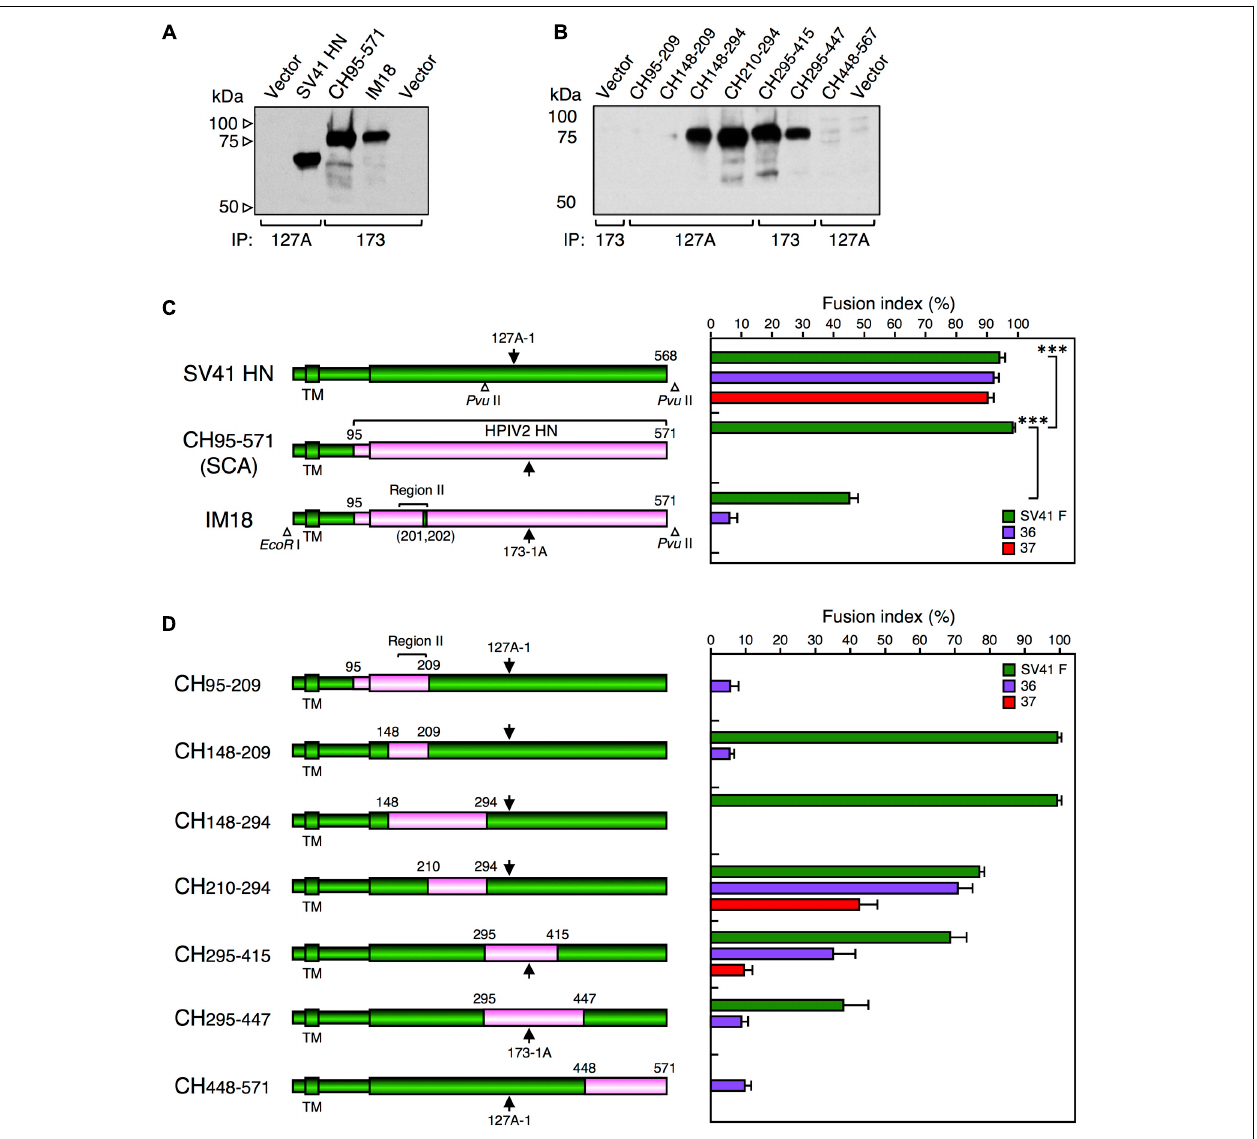
FIGURE 4 | Middle region of the SV41 HN protein is not required for activating the SV41 F-like chimeric proteins. (A,B) Detection of cell surface-localized HN proteins. Subconfluent BHK cells in six-well culture plates were transfected with 2 µ g/well of the pcDL-SR α expression vector encoding each HN protein. At 24 h post transfection, the transfected cells were biotinylated, the cell lysates were subjected to immunoprecipitation (IP) with MAb 173-1A (173) or MAb 127A-1 (127A), the precipitates were subjected to SDS-PAGE under reducing conditions, and the HN protein bands were detected by ECL as described in the section “Materials and Methods.” Vector: pcDL-SR α expression vector used as the negative control. The SV41 HN protein migrates much faster compared to CH95-571 and IM18 as reported previously (Tsurudome et al., 2015), presumably reflecting the remarkable difference in the number of potential N -glycosylation sites between the HN proteins of SV41 and HPIV2 (Tsurudome et al., 1990): the SV41 HN protein (568 aa) migrates as a 67-kDa protein (Tsurudome et al., 1989) while the HPIV2 HN protein (571 aa) migrates as an 82-kDa protein (Ito et al., 1987; Tsurudome et al., 1990). (C,D) F protein specificity of the HN proteins. The average fusion index was determined at 24 h post transfection as described in the legend for Figure 2D ; error bars indicate standard deviation. The representative data of more than three independent experiments are shown. The fusion indices are not normalized to the cell surface-localization levels which could not be determined due to the use two detection antibodies. The statistical significance was evaluated by one-way ANOVA as described in the section “Materials and Methods” ( ∗∗∗ p < 0.01, n = 10). ns, not significant. Open triangles indicate the positions of restriction enzyme sites in the cDNA encoding the SV41 HN protein or IM-18. Arrows indicate the positions of epitopes for the two anti-HN monoclonal antibodies. The numbers above each cylinder denote the residue numbers of the HPIV2 HN fragments that had replaced the corresponding part of the SV41 HN